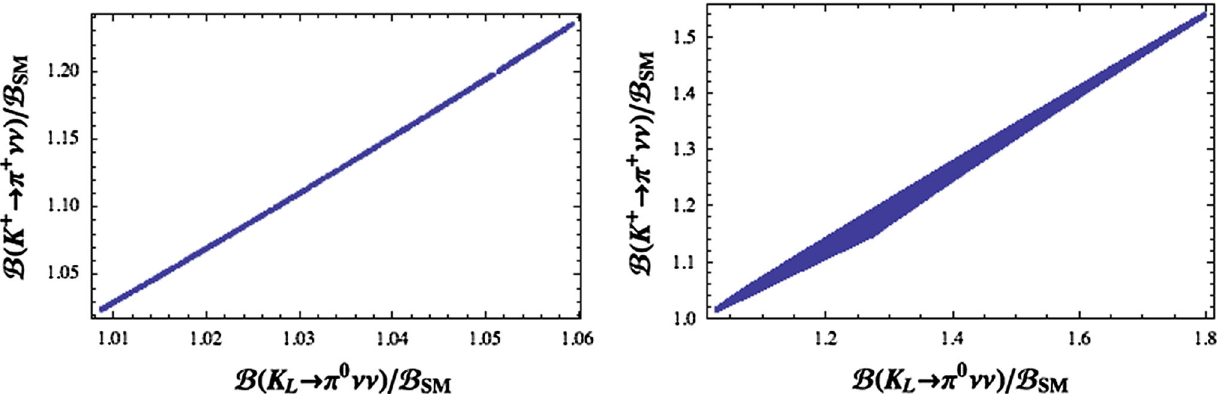
Fig. 9 Correlation between K + → π + ν ¯ ν and K L → π 0 νν for Scenario A (left) and Scenario B (right)